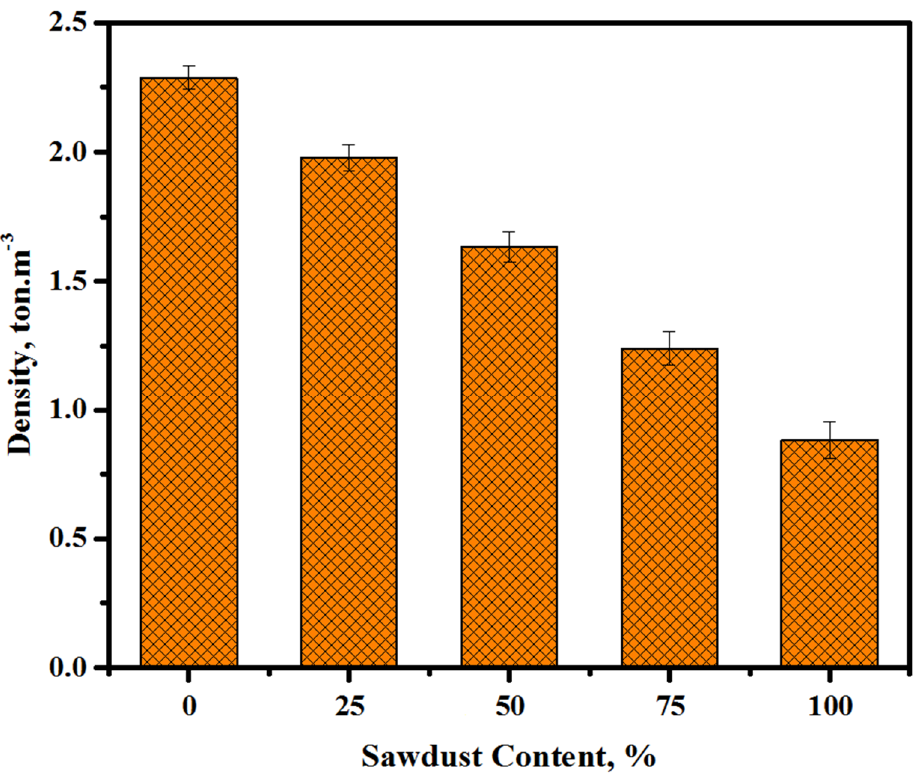
Figure 7. Densities of the prepared concretes with various sawdust contents.